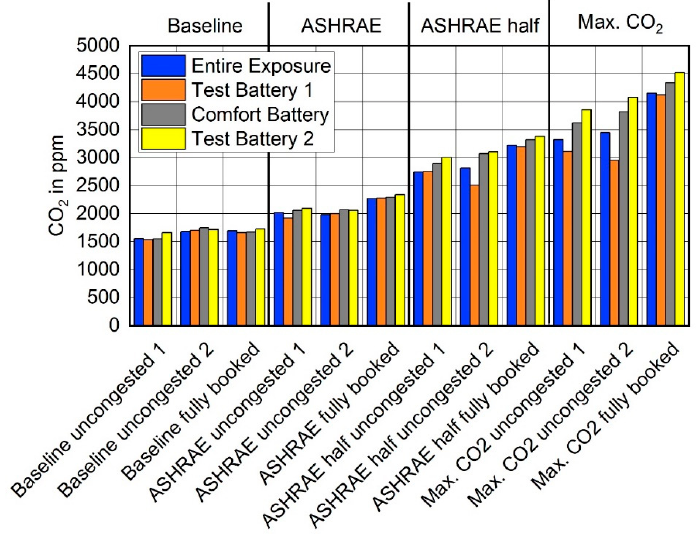
Figure 11. Measured average CO 2 concentration in the cabin (pressure corrected).